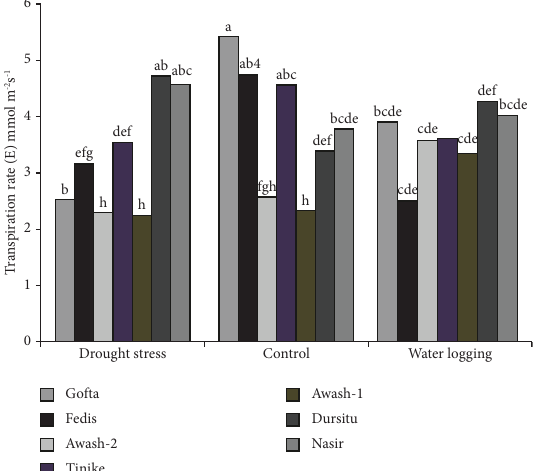
Figure 4: Varieties and irrigation interval interactions on the transpiration rate under lath house 2020.